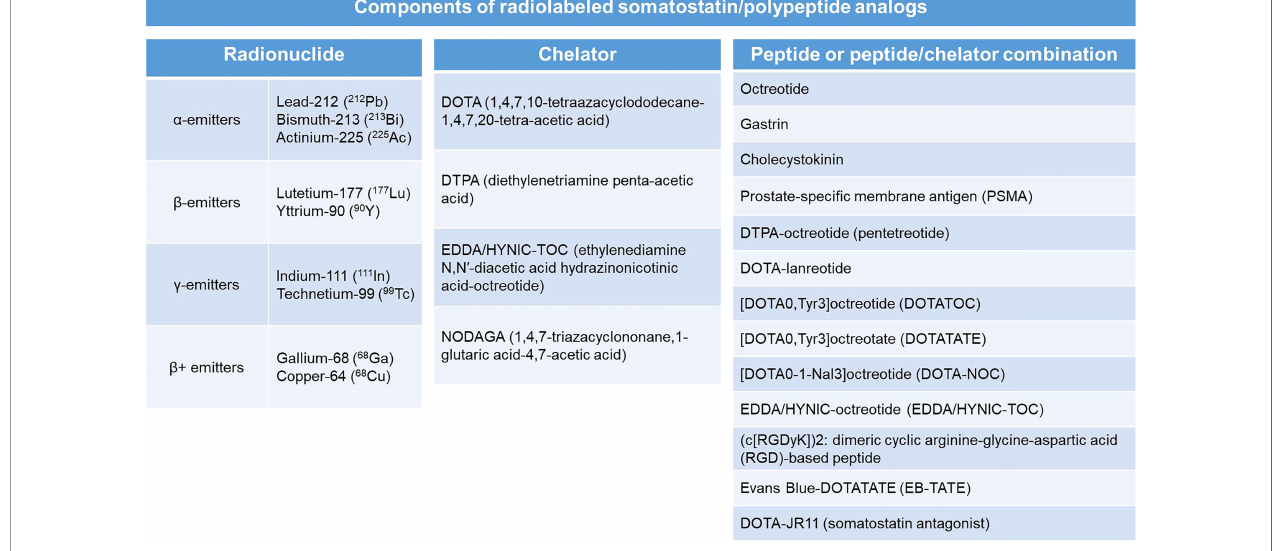
FIGURE 1 | Components of a radiolabeled somatostatin analog with individual examples of each